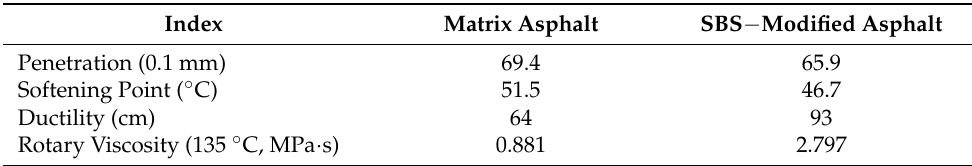
Table 1. The physical parameters matrix and SBS − modified asphalt. Index Matrix Asphalt SBS − Modified Asphalt Penetration (0.1 mm) 69.4 65.9 Softening Point ( ◦ C) 51.5 46.7 Ductility (cm) 64